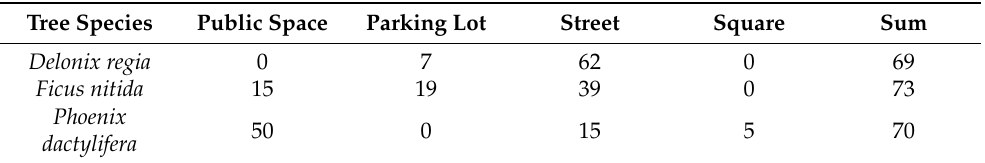
Table 1. The number of measured tree species for four different planting categories: public space, parking lot, street, and square.